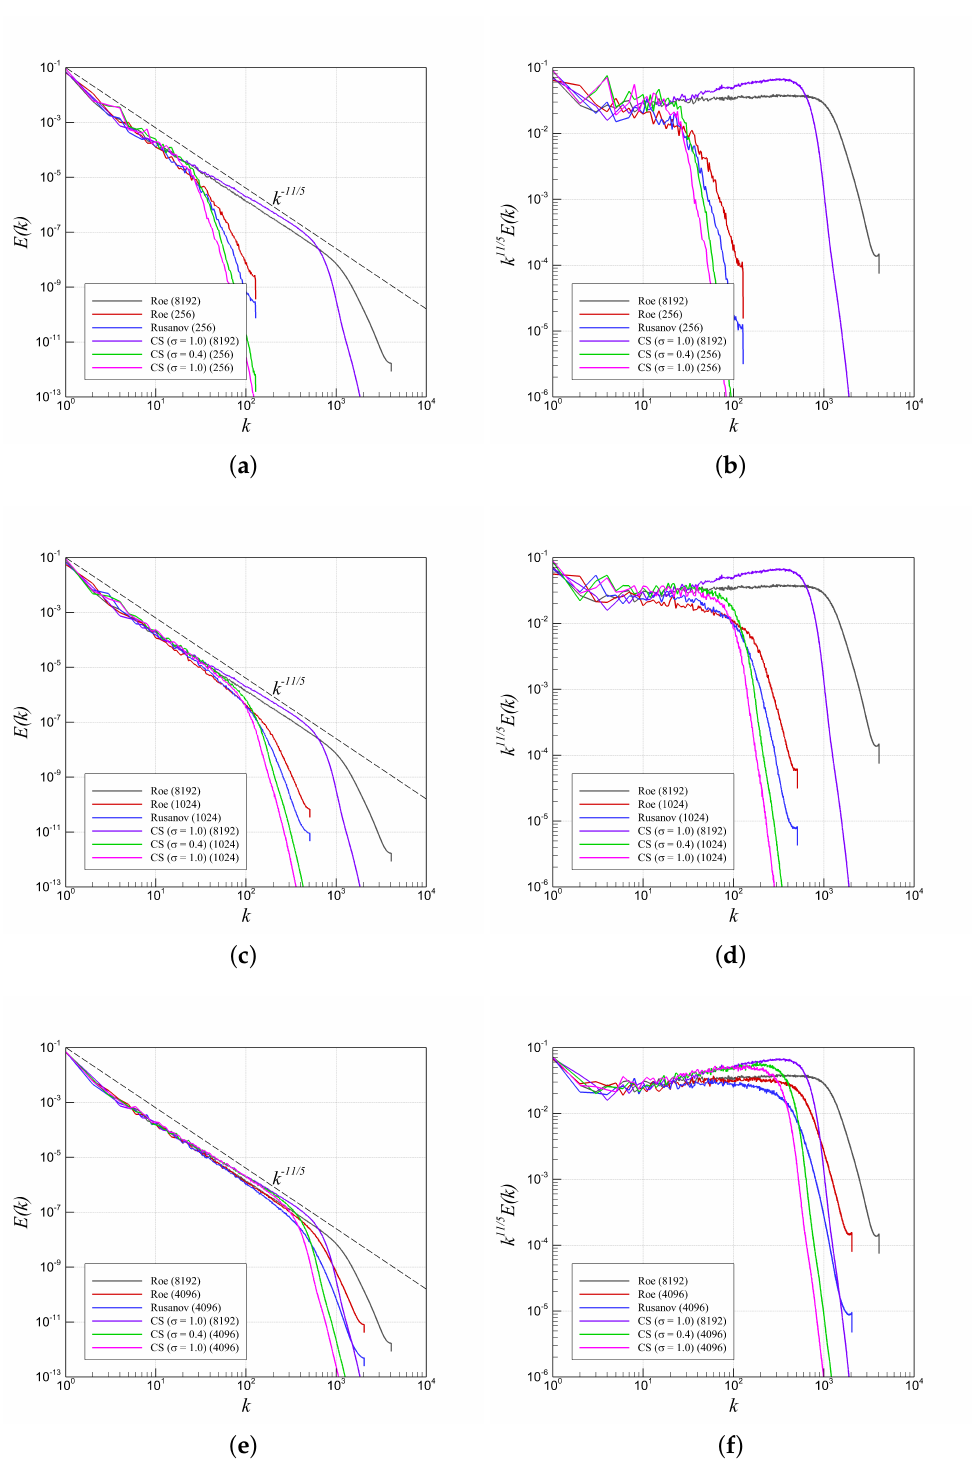
Figure 26. Comparison between ILES and CS+RF models for the RTI problem with single-mode perturbation at different resolutions; ( a ) density-weighted spectra at 256 × 768 resolution; ( b ) compensated density-weighted spectra at 256 × 768 resolution; ( c ) density-weighted spectra at 1024 × 3072 resolution; ( d ) compensated density-weighted spectra at 1024 × 3072 resolution; ( e ) density-weighted spectra at 4096 × 12288 resolution; ( f ) compensated density-weighted spectra at 4096 × 12288